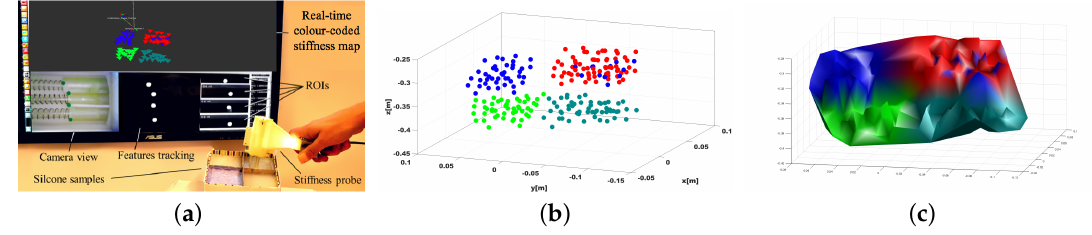
Figure 6. Stiffness mapping of homogeneous silicone phantoms: ( a ) the experimental setup; The discrimination between the different stiffness values of the silicone samples is visible in the coloured points in ( b ); The post-processed stiffness map is illustrated in ( c